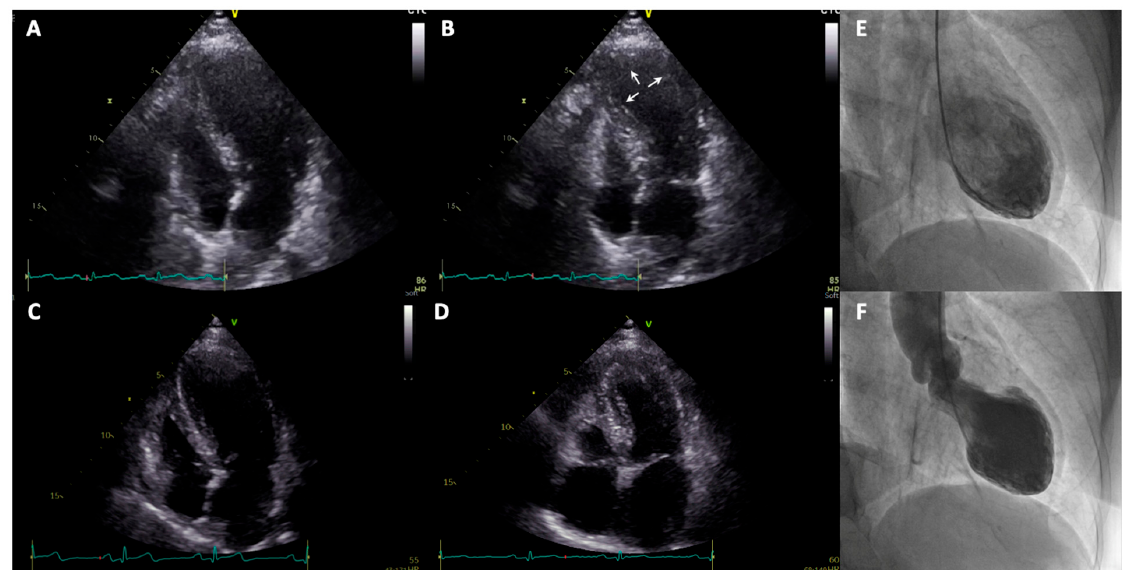
Figure 1. Apical 4-chamber view: in telediastole ( A ), in telesystole ( B ) showing apical ballooning (see arrows) in TTS on day 1; in telediastole ( C ), in telesystole ( D ) showing normal apical contractility on day 6. Left ventriculography (RAO 30 ◦ ) in telediastole ( E ), in telesystole ( F ) on day 1 showing apical ballooning and hypercontractility of basal segments resembling typical Japanese octopus pot. RAO: right anterior oblique.